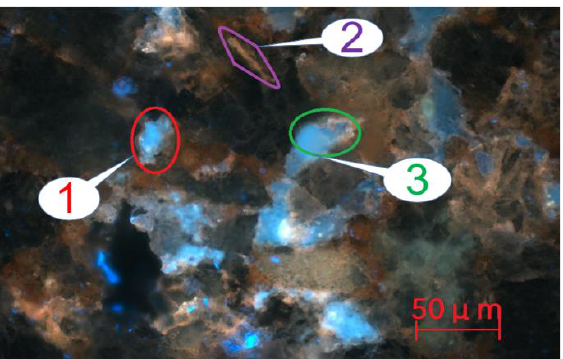
Figure 8. Schematic diagram of free-state remaining oil types.